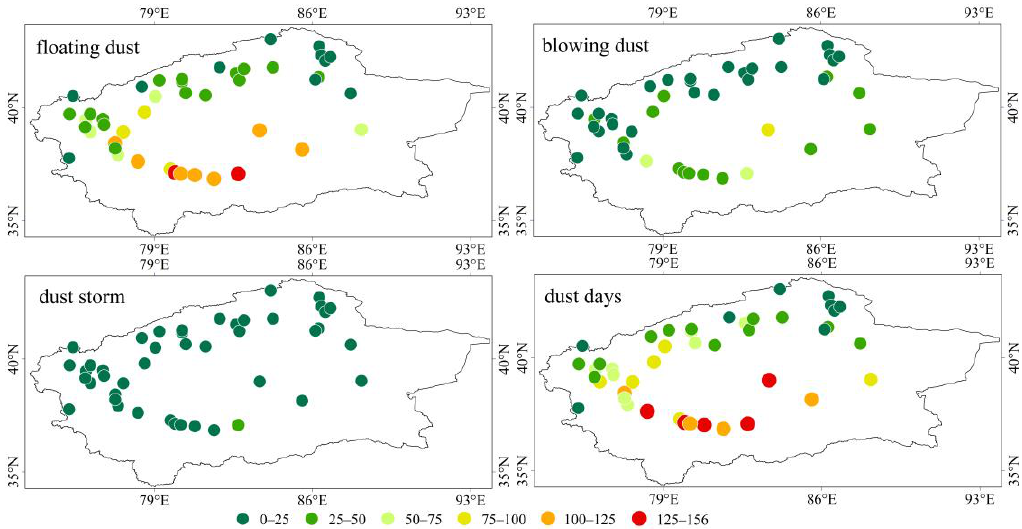
Figure 4. Annual average dust weather frequency in the Tarim Basin.